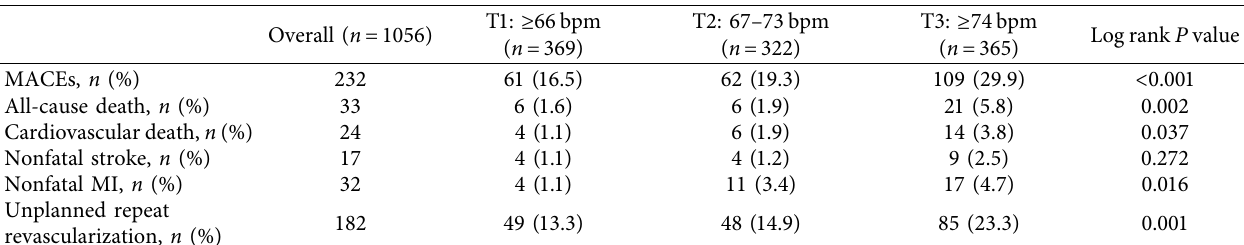
Table 2: Chi-square tests for clinical outcomes during follow-up stratified by admission heart rate